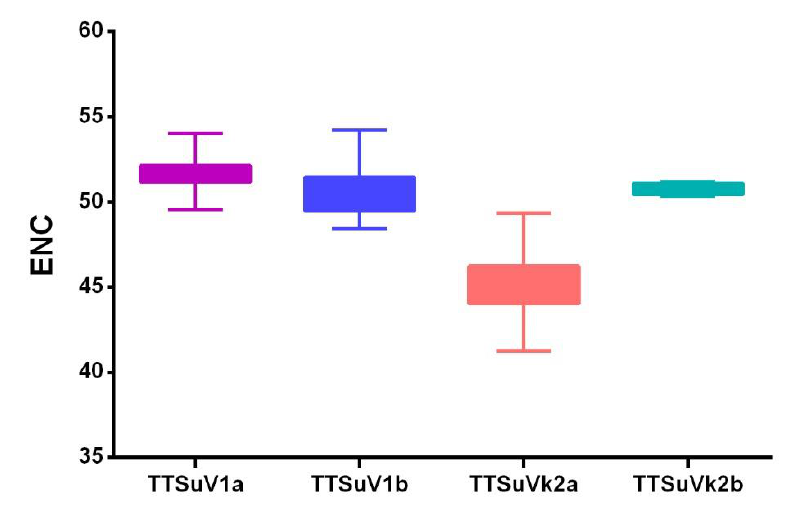
Figure 3. E ff ective number of codons (ENC) of TTSuV. TTSuV1a, TTSuV1b, TTSuVk2a, and TTSuVk2b Figure 3. Effective number of codons (ENC) of TTSuV. TTSuV1a, TTSuV1b, TTSuVk2a, and are represented in purple, blue, pink, and green, TTSuVk2b are represented in purple, blue, pink, and green, respectively.